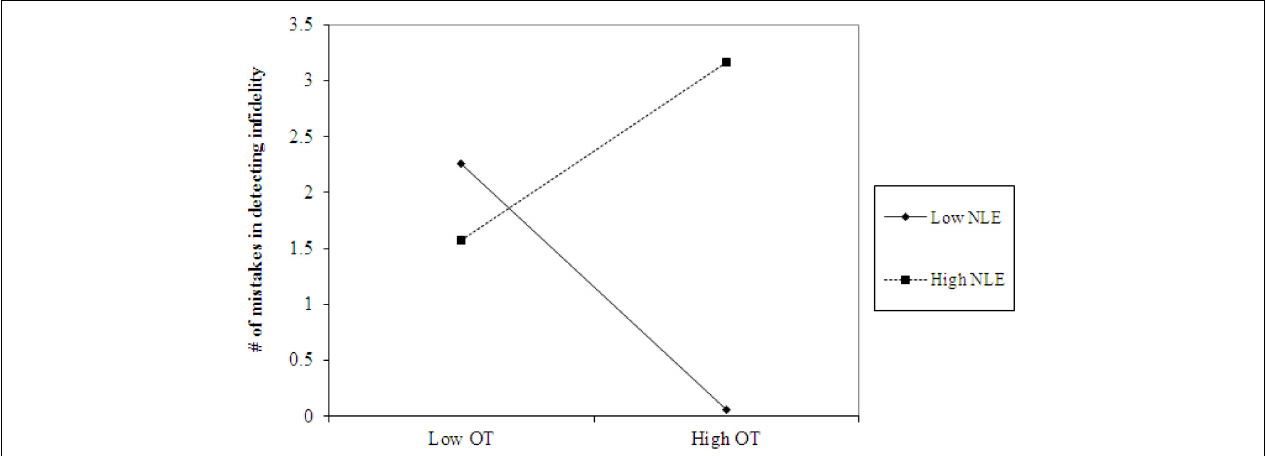
FIGURE 3 | Accuracy in detecting infidelity (number of mistakes) as a function of OT and early life stress (NLE). High OT was linked with lower accuracy (more mistakes) in detecting infidelity among people with high early life stress (i.e., not seeing flaws), but with higher accuracy among people with low early life stress and safer environments (i.e., greater sensitivity to social